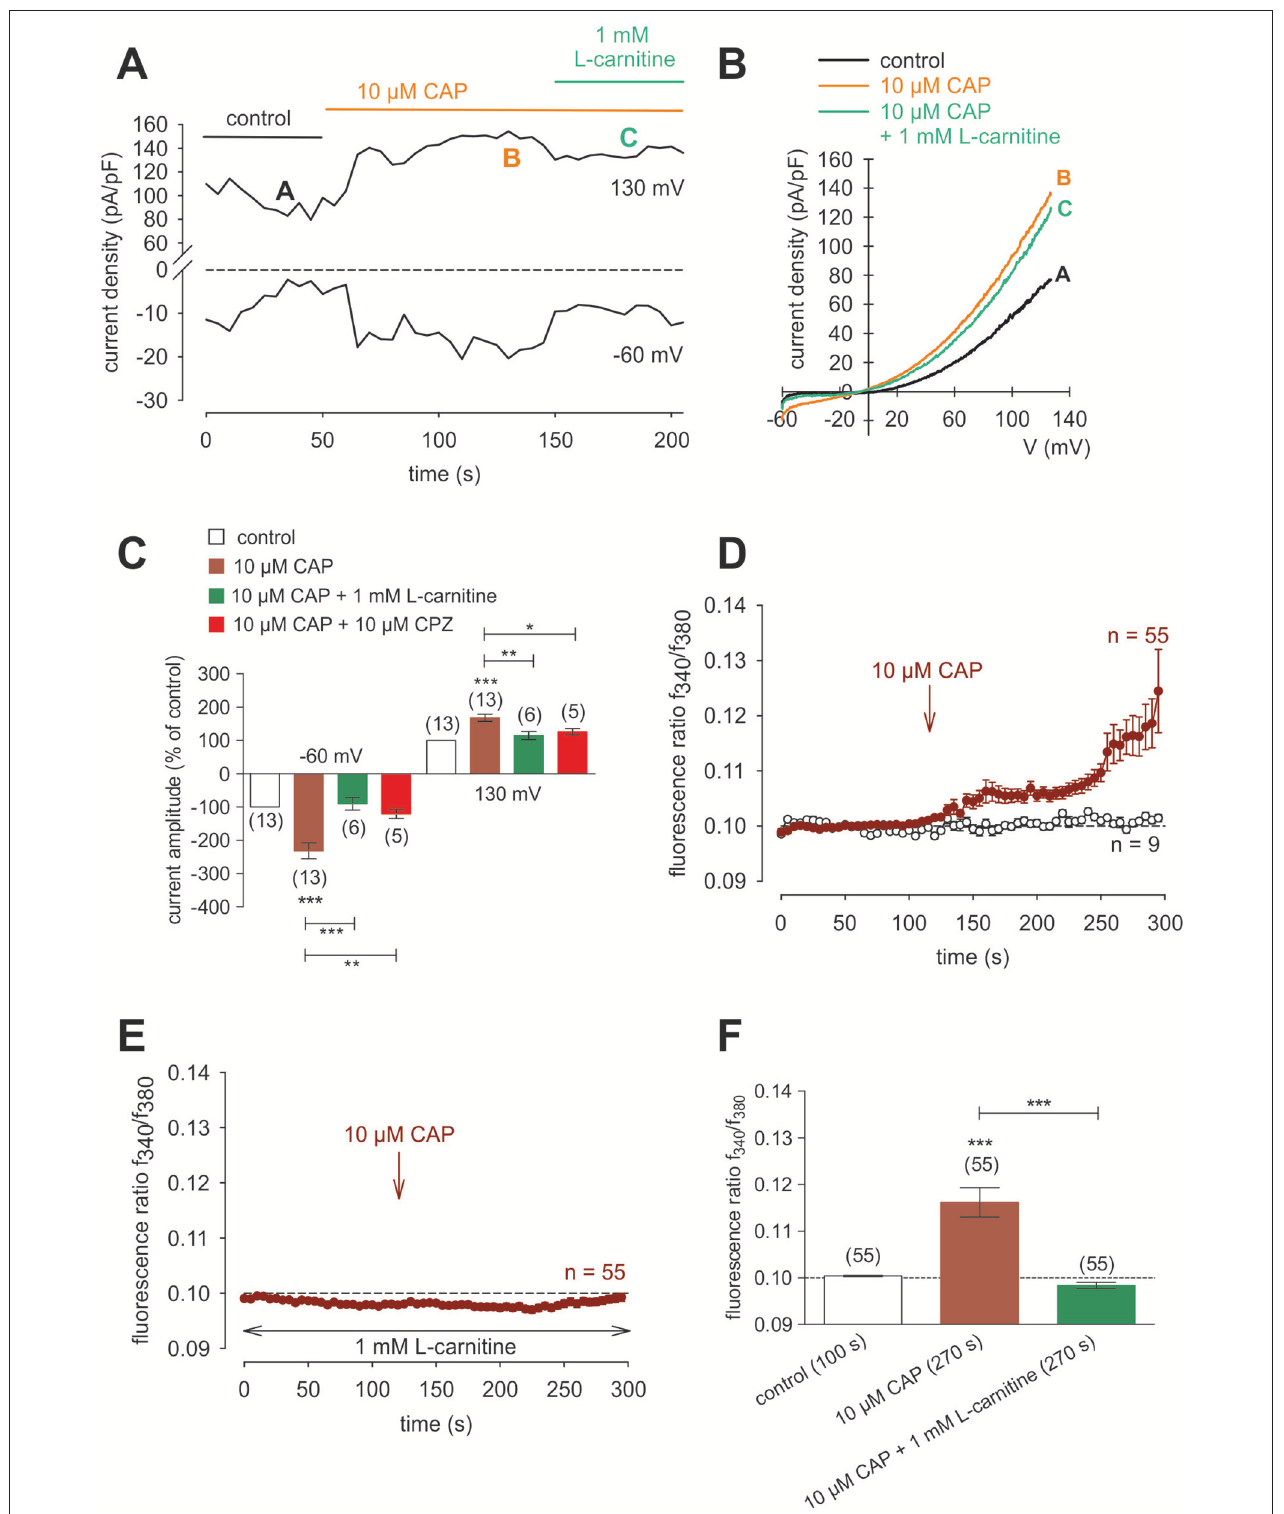
FIGURE 5 | CAP activated whole-cell currents in HCK. (A) Time course recording of the current increases induced by CAP (10 µ M) and decline after application of 1mM L-carnitine. (B) Original traces of CAP-induced current responses to voltage ramps. Current densities are shown before application (labeled as A), during application of 10 µ M CAP (labeled as B), and after addition of 1mM L-carnitine (labeled as C). Calculated current densities obtained by normalizing currents to